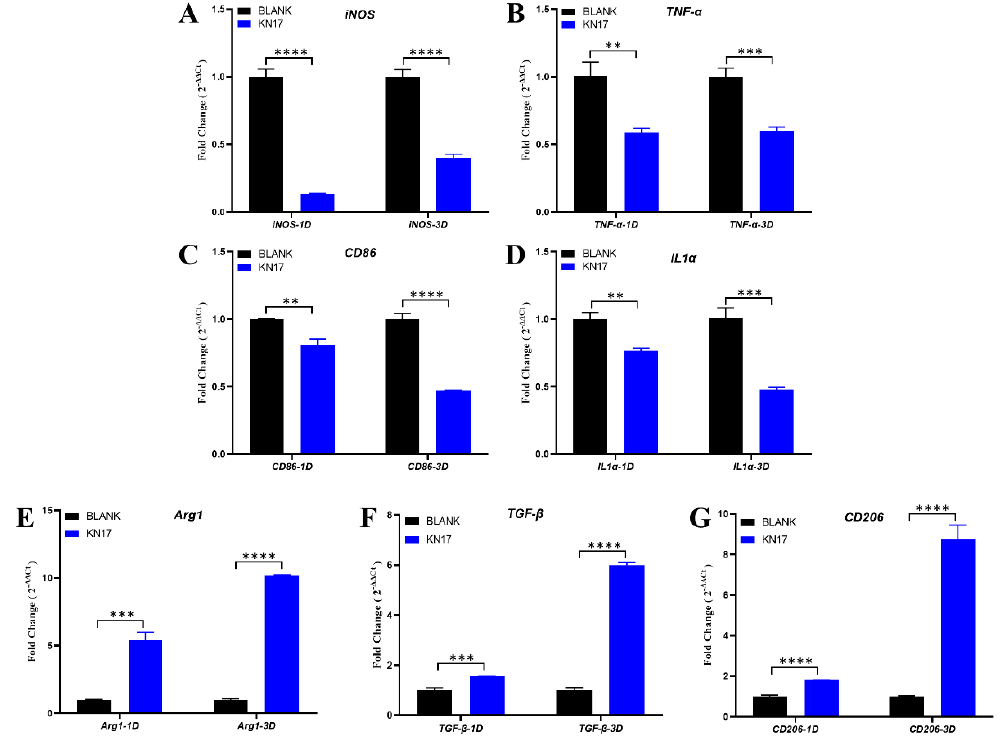
Figure 7. Under non-inflammatory conditions, KN-17 was added to culture RAW 264.7 cells for day 1 and day 3, respectively, and the changes in the expression of inflammation-related genes were detected by qPCR. ( A – D ) The levels of expression of pro-inflammatory related genes. ( E – G ) The levels of expression of anti-inflammatory-related genes. Note: Data are presented as mean ± SD; n = 3. *** Indicates statistical significance between the BLANK group and KN-17 group. (** p < 0.01, *** p < 0.001, and **** p < 0.0001, ANOVA).